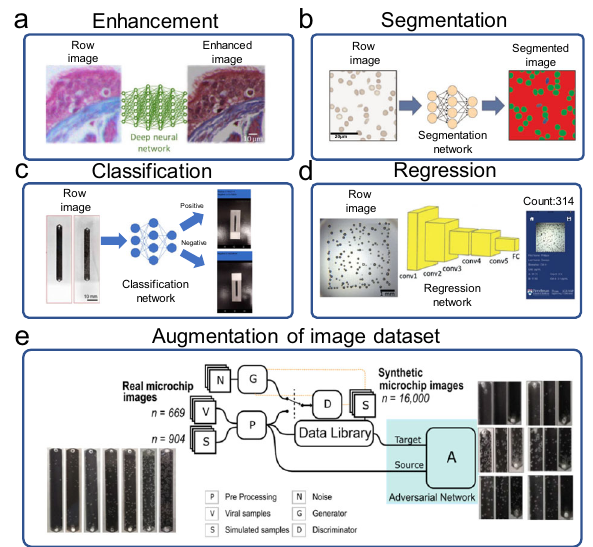
Fig. 7 | Deep learning algorithms for mHealth platforms.a Image enhancement. The fi gure shows the process of using deep learning to enhance low-quality images capturedbymobilephones( fi gureadaptedwithpermissionfromRivensonetal. 107 ). b Imagesegmentation.The fi gureillustratesadeeplearningwork fl owemployingthe U-net architecture for sickle cell analysis ( fi gure adapted with permission from Haan et al. 36 ). c Image classi fi cation. The fi gure illustrates the detection of an on-chip bubble signal by using a CNN employing Inception v3 architecture ( fi gure adapted with permission from Draz et al. 109 ). d Regression. The fi gure illustrates the regres- sionCNNstructureforcountingbubbles( fi gureadaptedwithpermissionfromChen et al. 110 ). e Augmentation of the image dataset. The fi gure illustrates the structure of GAN for generating realistic synthetic micro fl uidic chip images to augment the image dataset ( fi gure adapted with permission from Shokr et al. 111